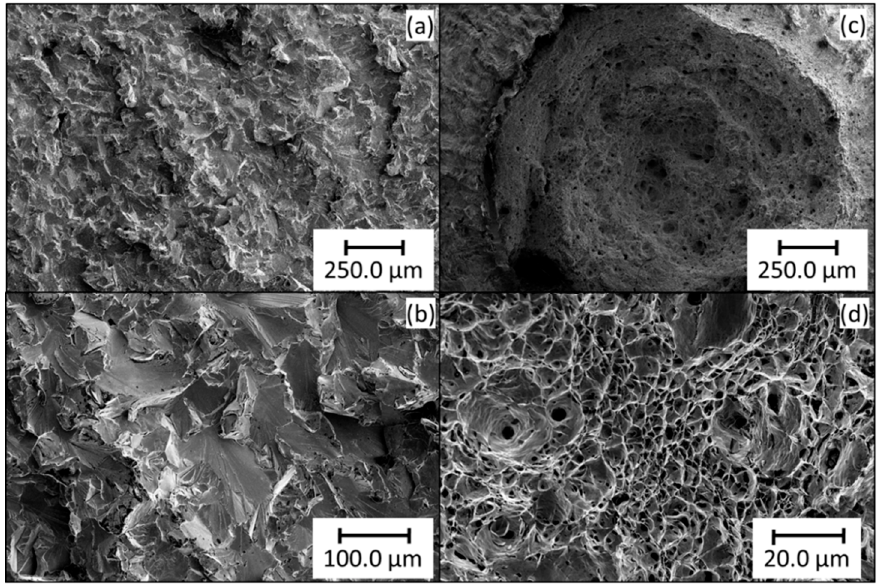
Figure 5. Fractographs of AM Hiperco in the ordered ( a , b ) and quenched ( c , d ) conditions.